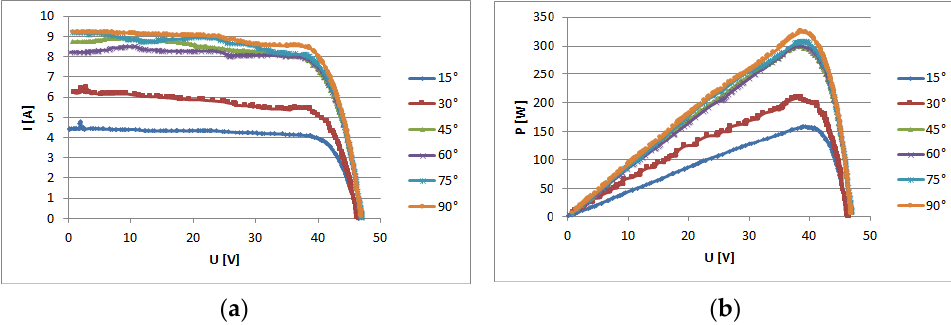
Figure 8. The bifacial module’s characteristics—measurements for white substrate: ( a ) current-voltage characteristics; ( b ) power-voltage characteristics. Table 6. Results of measurements and calculations for a white substrate.